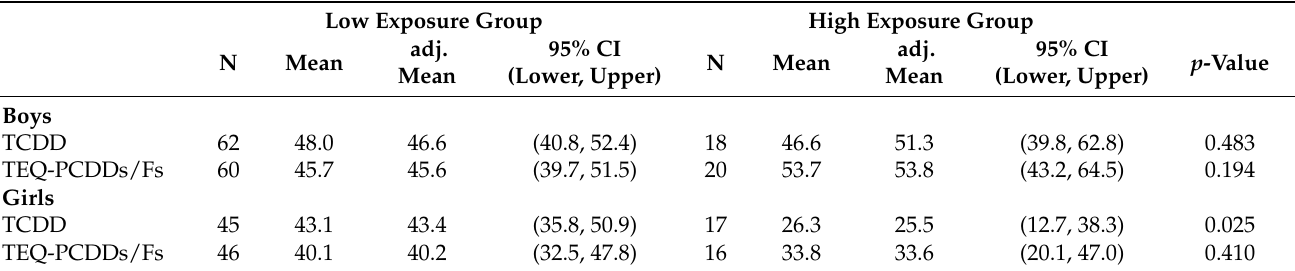
Table 3. Comparison of the adjusted mean face fixation duration (%) between the high and low dioxin exposure